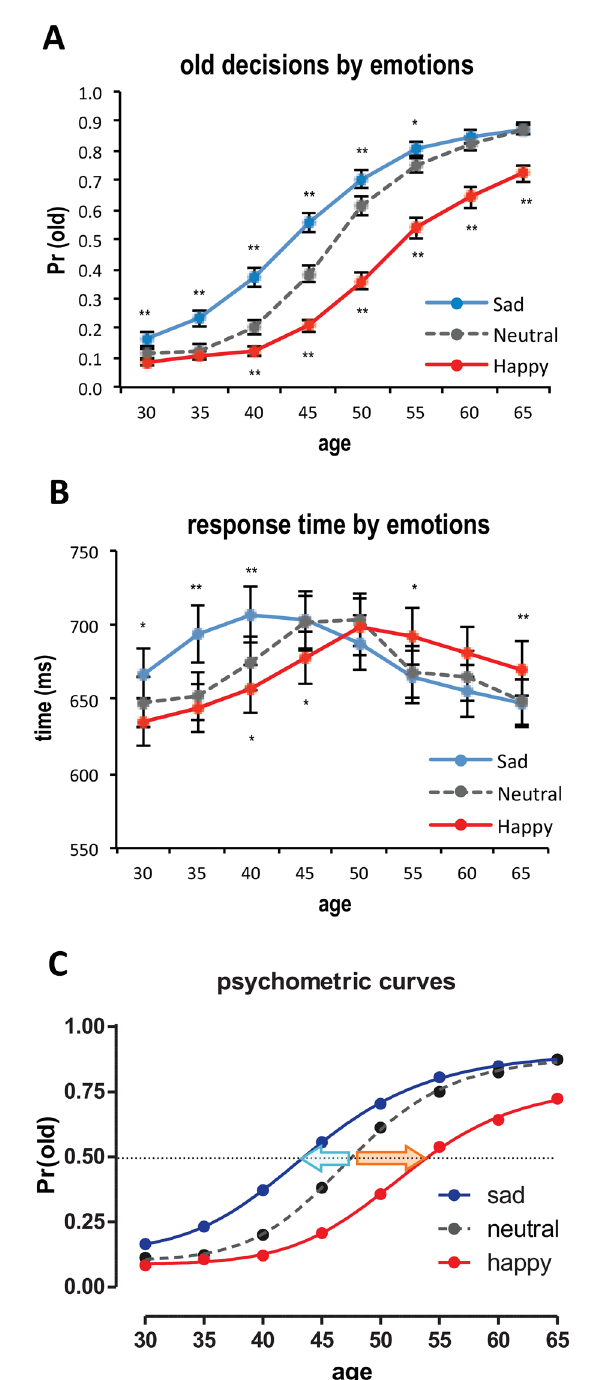
Fig 2. A. Average probability of old responses as a function of age and emotional expressions of faces . B. Response times of age decisions. Error bars denote the standard error of the mean. * p < .05, ** p < .01 compared to neutral faces (controls). C. Psychometric curve fits. For each emotional expression, psychometric curves were separately fitted by using the Naka-Rushton response function. A leftward-shift of the psychometric curve of sad faces (blue line) and a rightward-shift of the psychometric curve of happy faces (red line) compared to neutral faces (gray line) were observed. A dotted horizontal line represents the 50% probability of an old decision.